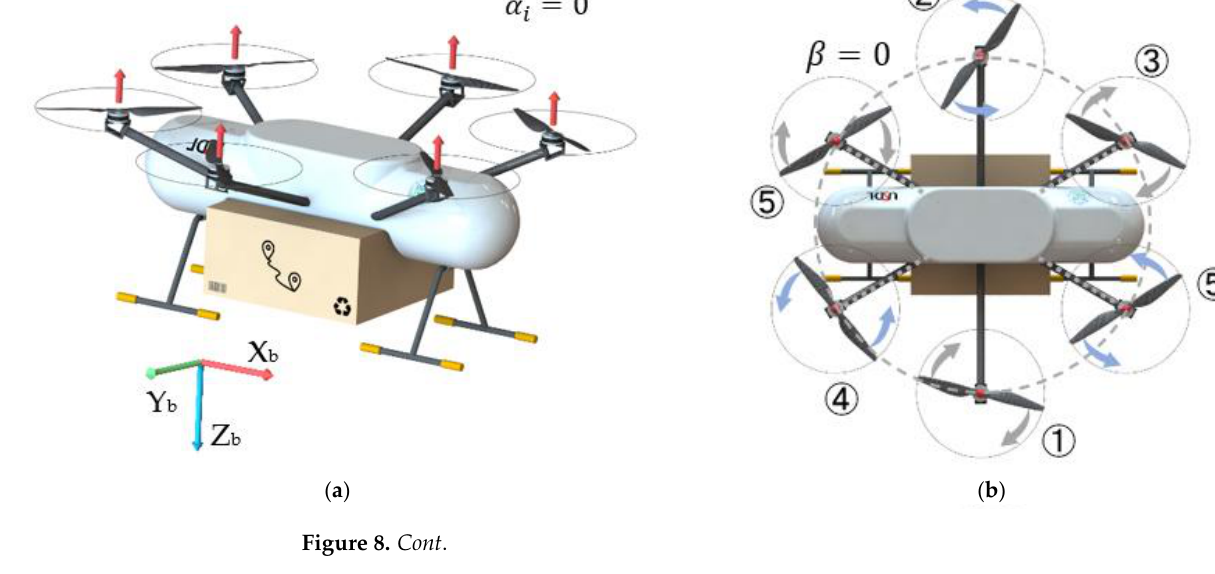
( d ) Figure 8. Comparison of proposed UAV preliminary design and UAV with tilting mechanism ( a ) preliminary design where all propellers tilting angles are zero (coplanar) ( b ) preliminary design with axis offsetting angle zero ( c ) 𝛼 𝑖 tilted propeller configuration ( d ) configuration with axis offset angle 𝛽 . The design parameters to be optimized were chosen as: 𝑝 = [𝛽, 𝛼 1 , 𝛼 2 , 𝛼 3 , 𝛼 4 , 𝛼 5 , 𝛼 6 ] 𝑇 (12) where 𝛼 𝑖 is the propeller ’ s tilting angle, and 𝛽 is the lateral thrust offsetting angle; the out- ward tilting angle was taken as a positive tilting angle. 6. Result and Discussion 6.1. Optimization Result The proposed framework ’ s verification by optimizing parameters in 𝑝 for each actu- ator failure possibility in the platform and chosen post-failure operation performance re- quirement is presented. The two common operations, hovering at the location and follow- ing an obstacle-free trajectory to return home, are considered. The required moment data to accomplish these operations and reject the associated disturbance in the nominal con- dition were logged from the simulation and used as a performance requirement for